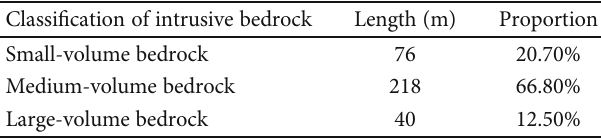
Figure 6: Granite crushing degree and crushing form with various excitation pressures. Table 4: Classi fi cation of intervals of intrusion